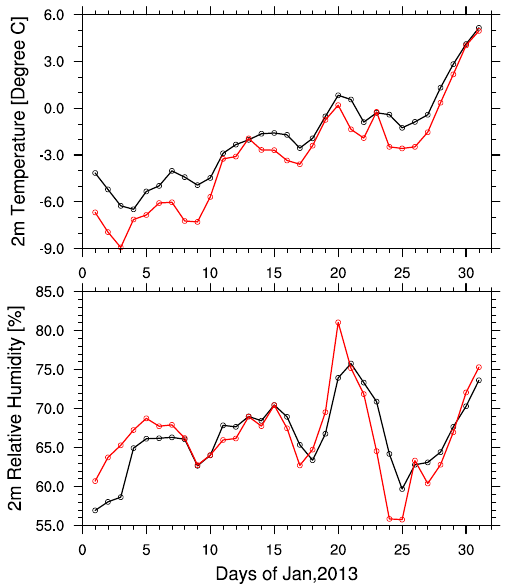
Figure 2. Time series of observed (black line) and simulated (red line) daily meteorological variables averaged over 523 meteorology stations in January 2013.